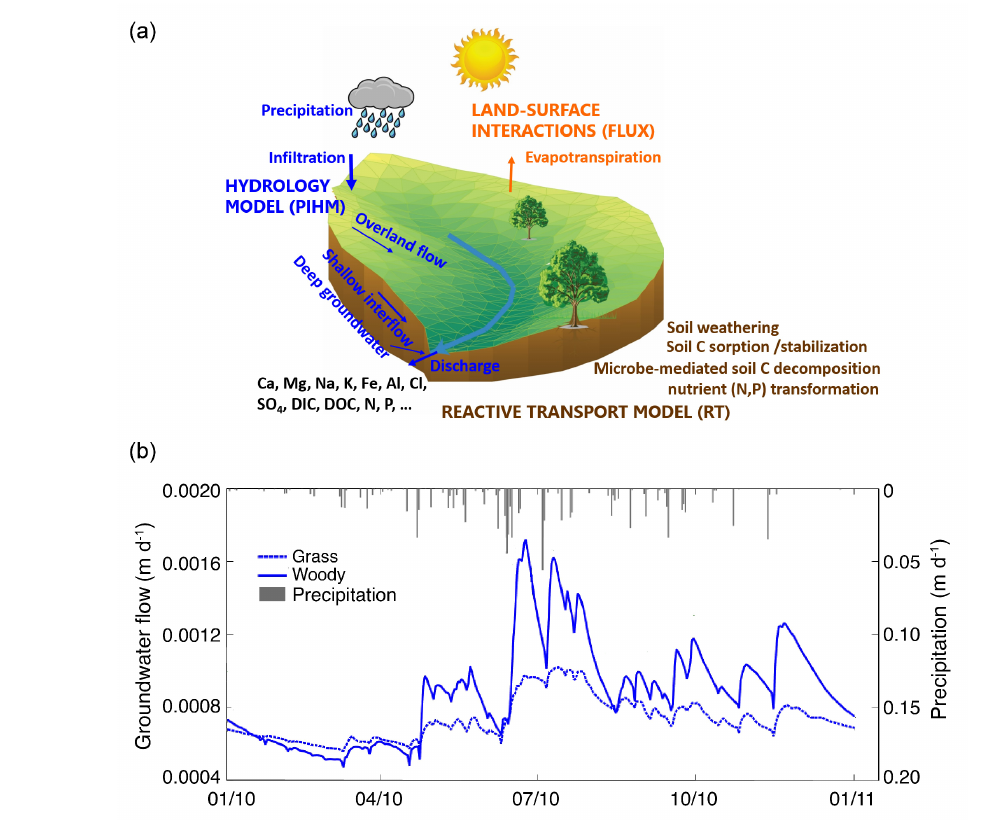
Figure 5. (a) Representative processes from different disciplines (different colours) in different modules that can be integrated into one model suite or a coupled reactive transport–land surface–hydrologic model RT-Flux-PIHM (Bao et al., 2017). The integration among pro- cesses from mechanistic bases in the model will allow systematic understanding at the watershed scale. (b) Model result of simulated difference in groundwater flow for a grassland (dotted line) and woody encroached (solid line) watershed (N04-D), at the Konza Prairie, KS (USA). Grassland simulations are parameterized with a 0.3m rooting depth and enhanced horizontal macropore development, while woody encroached simulations have a rooting depth that extends to 1.0m